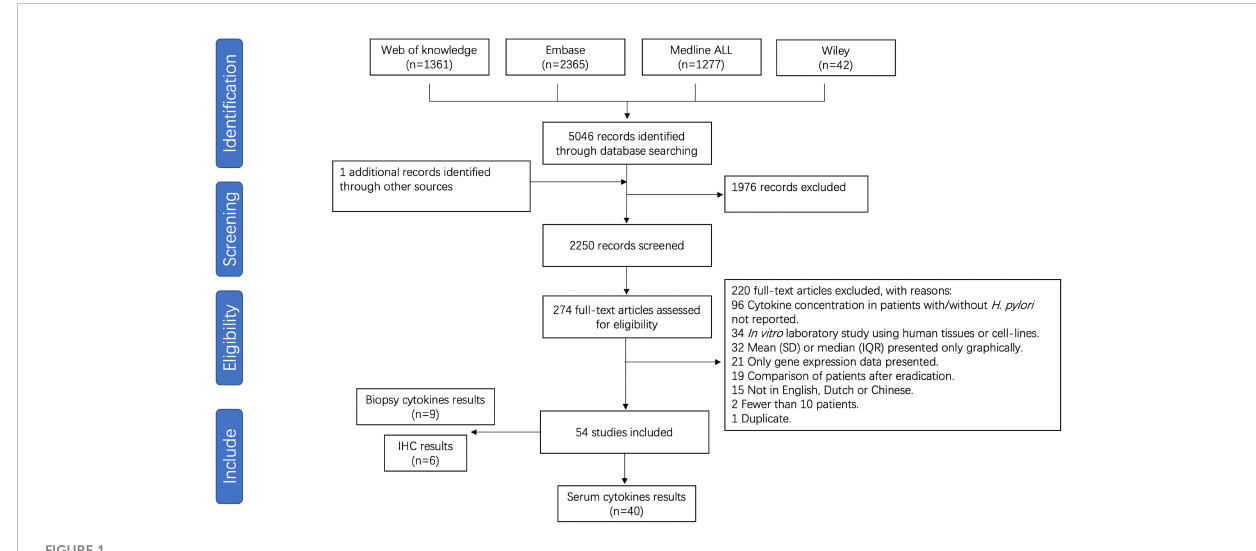
FIGURE 1 Flow chart of study selection for H. pylori infection